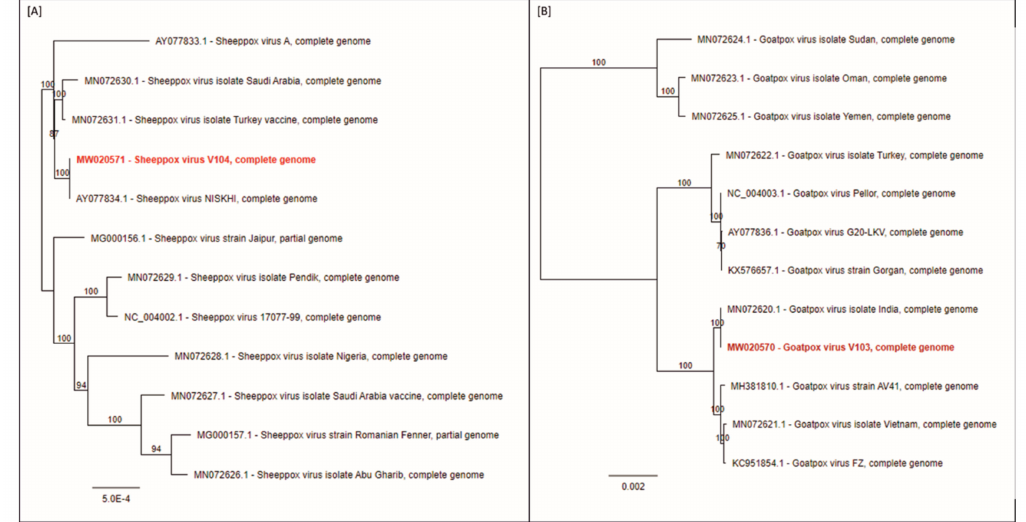
Figure 3. Phylogenetic trees displaying the relationship of the sequenced SPPV-“V / 104“ and GTPV-“V / 103“ strains. Nanopore and Illumina data were used in a hybrid assembly in an iterative mapping approach to gain full length, high quality consensus sequences. Phylogenetic relationship of ( A ) SPPV-“V / 104“ and ( B ) GTPV-“V / 103“ are